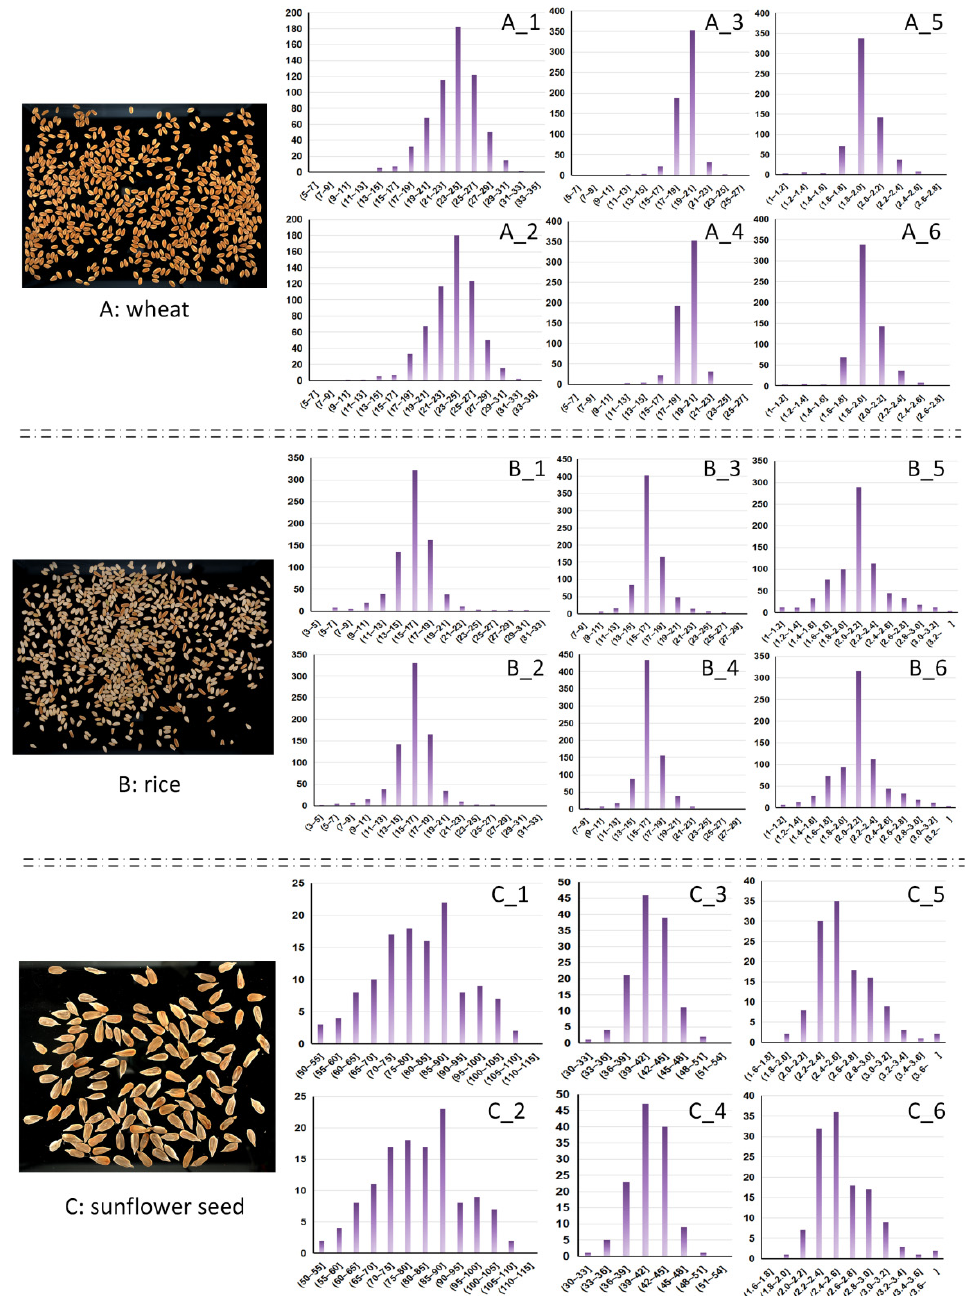
Figure 8. The size distribution results of a wheat image ( A ), a rice image ( B ), and a sunflower seed image ( C ). As for each result, the top row represents the perimeter distribution, the area distribution, and the long–short axis ratio distribution in our segmented instances, respectively. The bottom row represents the perimeter distribution, the area distribution, and the long–short axis ratio distribution in manually sketched instances, respectively.